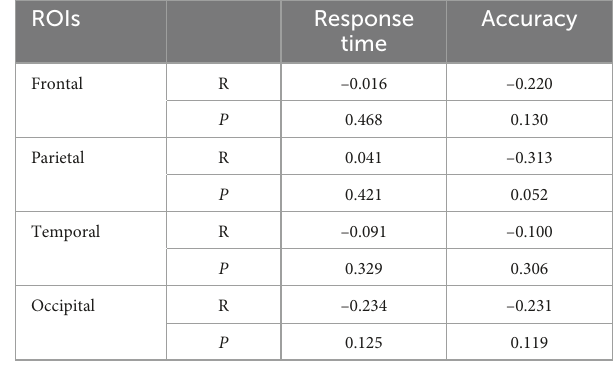
TABLE 2 Correlation coefficients between alpha event-related spectral perturbation (ERSP) values and behavioral data (150 ◦ of angle disparity). ROIs Response time